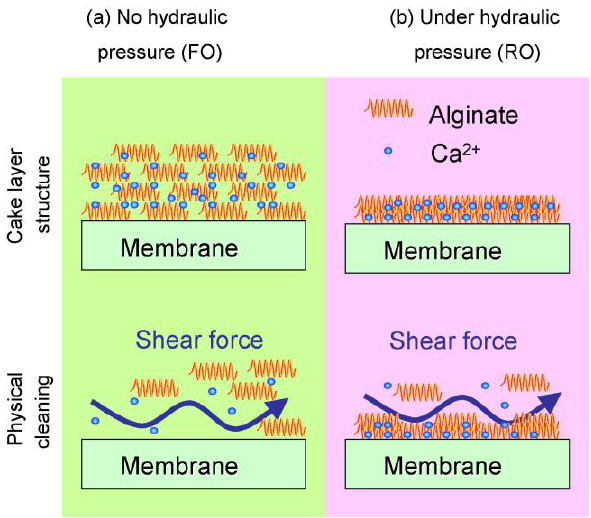
Figure 4. Schematic illustration of the fouling and cleaning with and without hydraulic pressure. ( a ) Loose alginate fouling layer due to the lack of hydraulic pressure, which permits effective physical cleaning; ( b ) Compact alginate fouling layer formed under hydraulic pressure, which results in low cleaning efficiency. Reprinted from [5], with permission from Elsevier.